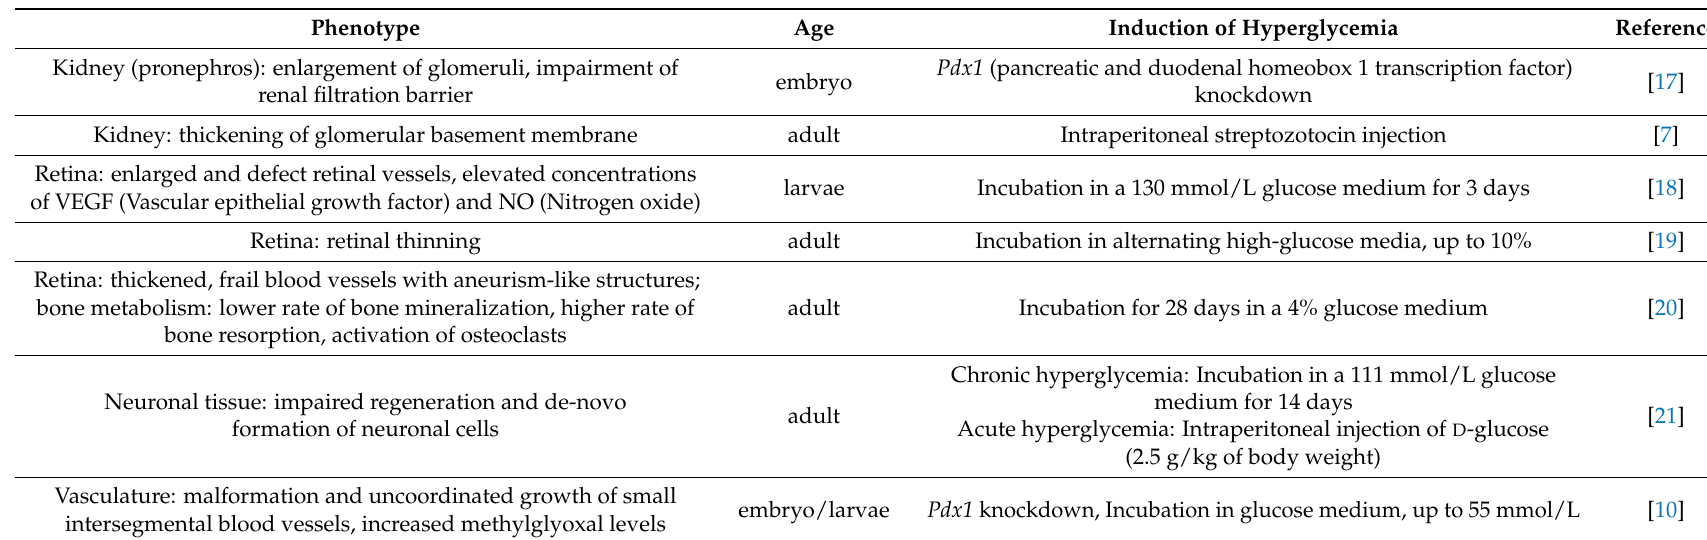
Table 1. Phenotypes found in different zebrafish models for hyperglycemia.